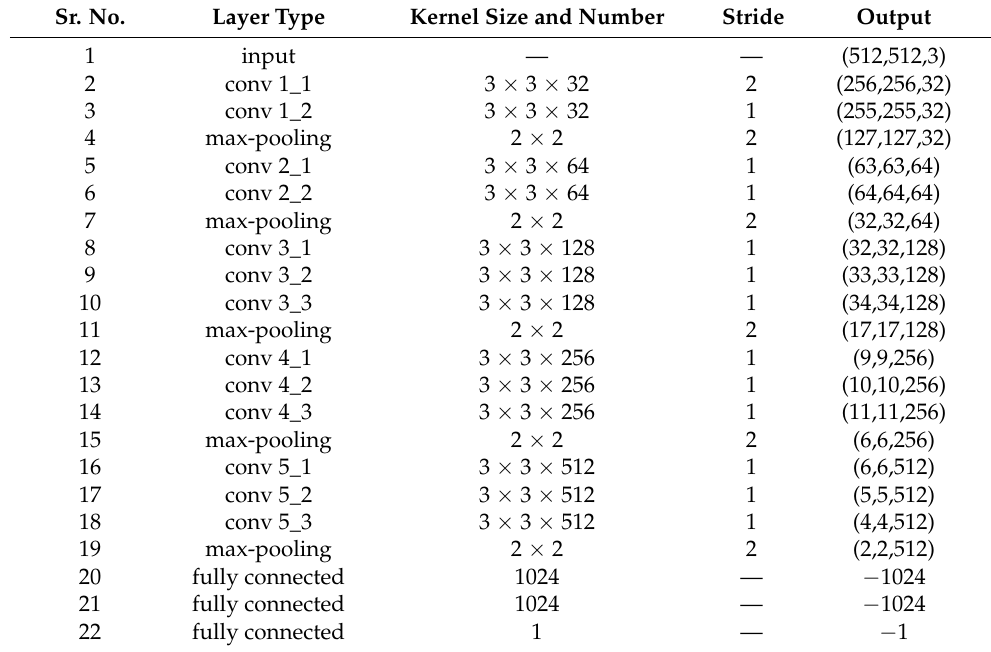
Table 3. The proposed architecture for early-stage detection and classification of diabetic retinopathy comprising of 16 layers.